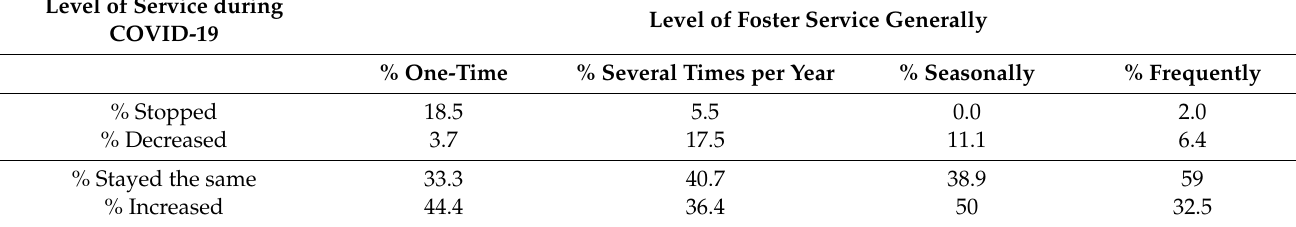
Table 3. Crosstabs, general level of foster service and service increase during COVID-19 ( n = 569).